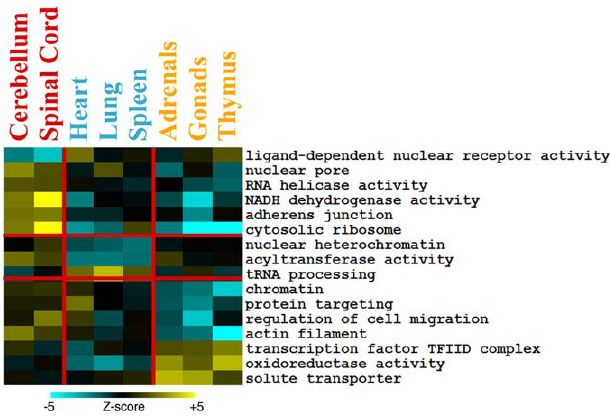
Figure 2. Differences in Age Regulation among Steroid-Responsive, Neural, and Vascular Tissues Columns refer to tissues, and rows correspond to gene sets. Vertical red bars divide tissues into neural, vascular, and steroid-responsive tissue groups from left to right. Tissue names are colored to indicate affiliation with either neural (red), vascular (blue), or steroid-responsive (yellow) tissue groups. Horizontal red bars divide gene sets into those chosen for being particularly age-regulated in steroid-responsive, neural, or vascular tissues ( p -value , 0.001, all j Z j . 1.0, p -value . 0.5 in remaining two tissue groups) from top to bottom. Scale indicates van der Waerden Z - scores as determined by Gene Set Enrichment Analysis. A navigable version of this figure is available at http://cmgm.stanford.edu/ ; kimlab/ aging_mouse.doi:10.1371/journal.pgen.0030201.g002